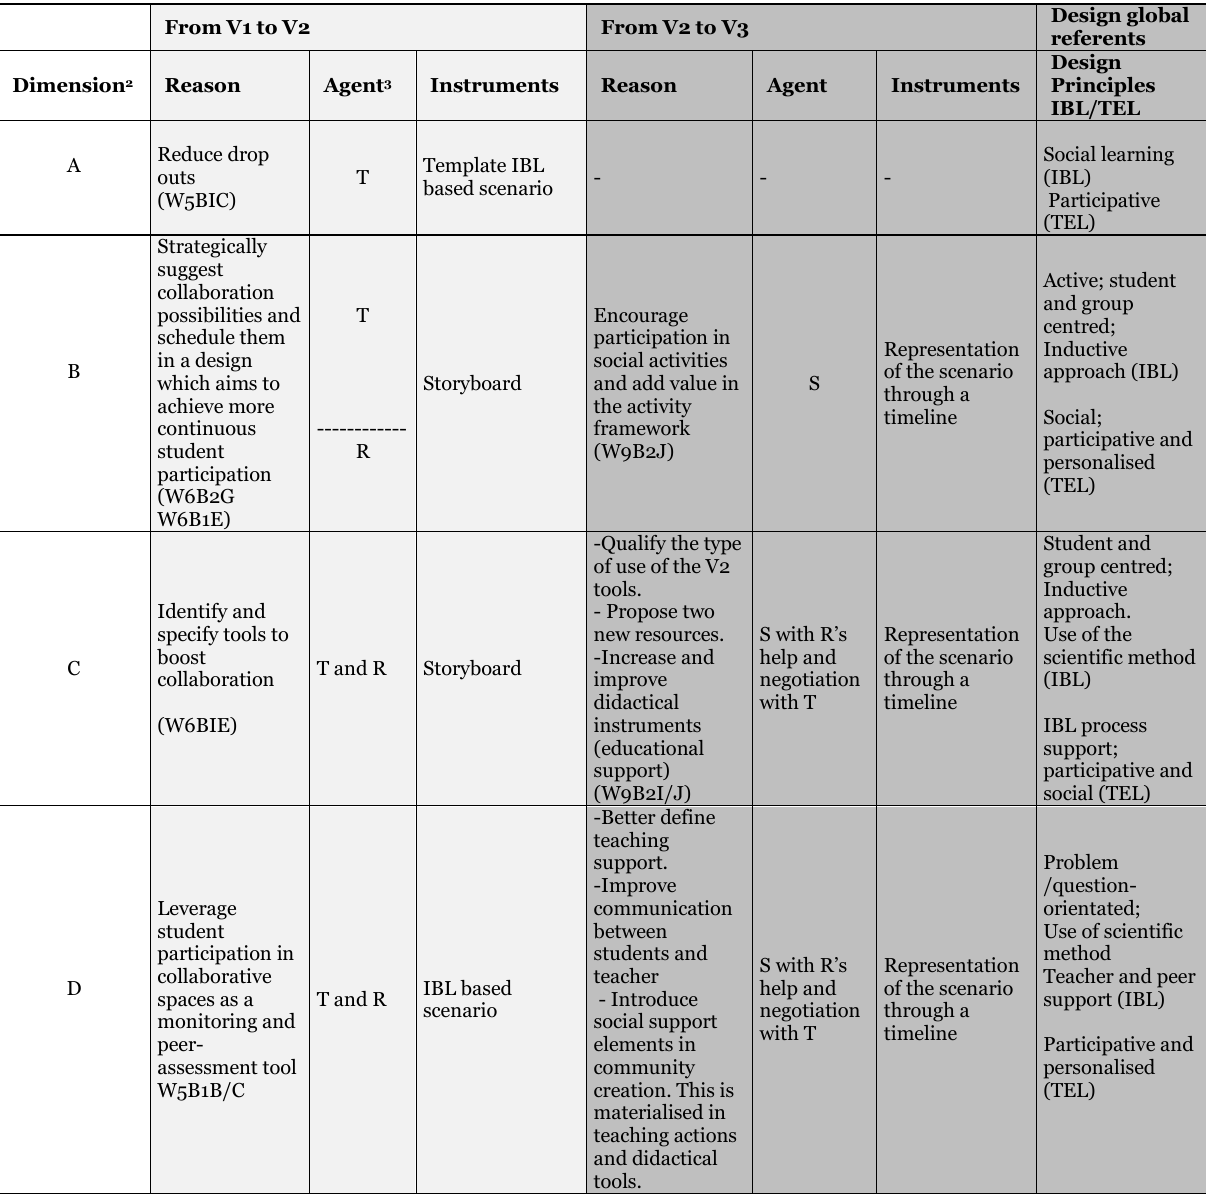
Summary of change reasons and agents from V1 to V2 and from V2 to V3 From V1 to V2 From V2 to V3 Dimension